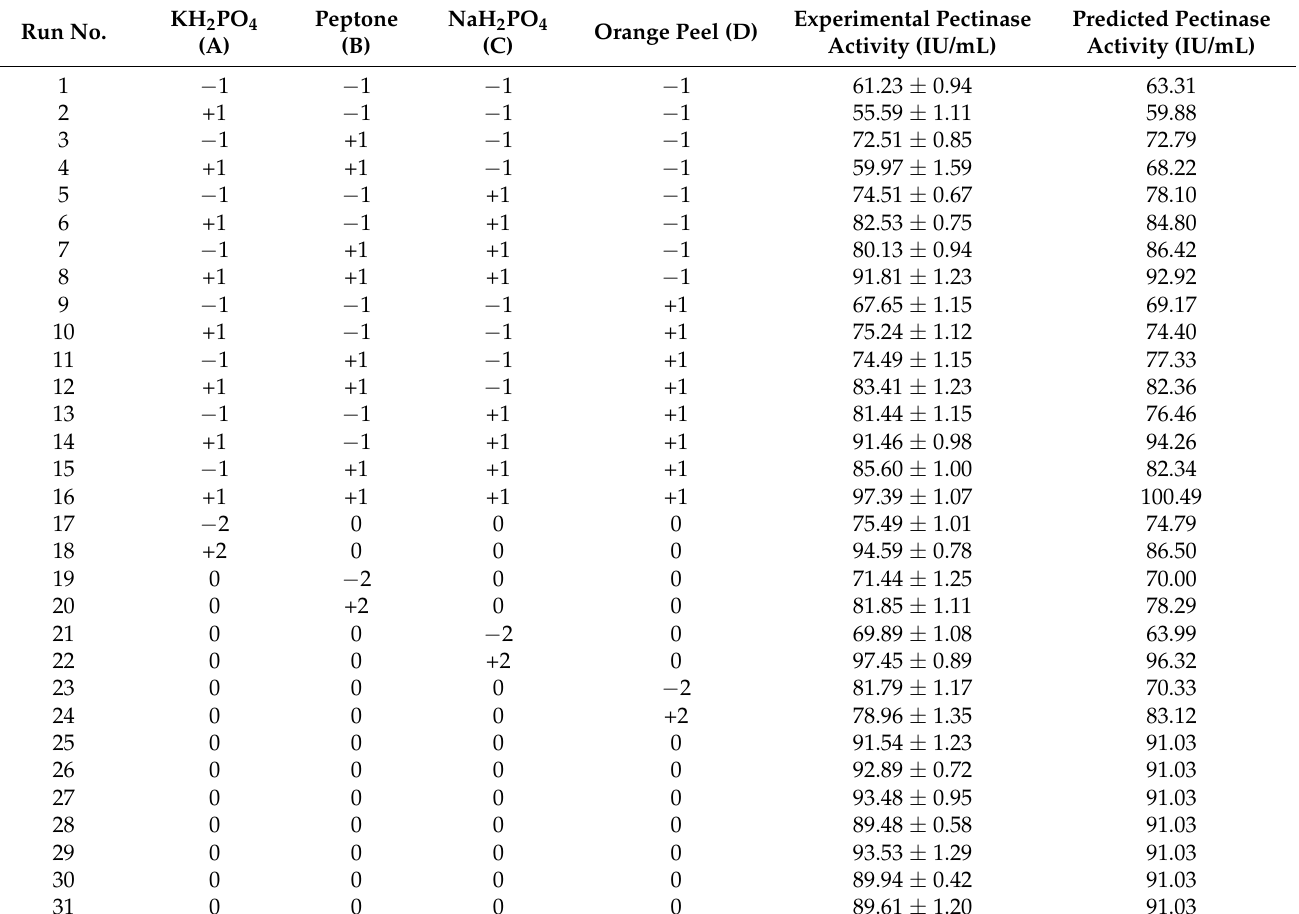
Table 11. The CCD matrix for the media components with the experimental and predicted